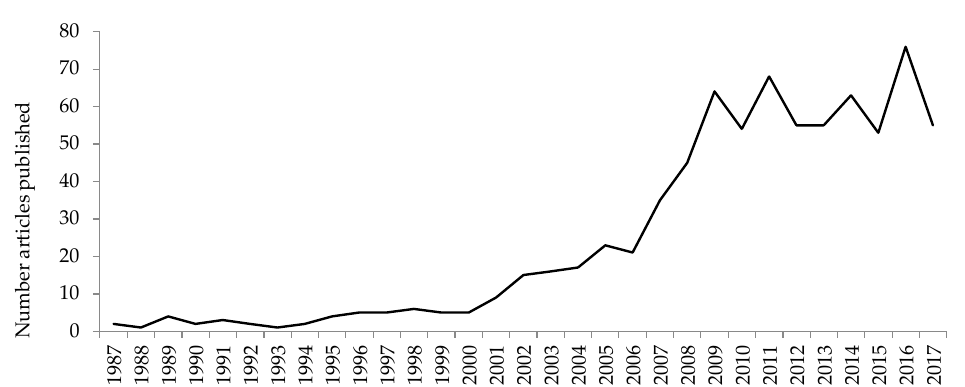
Figure 2. The number of articles published by year (1987–2017) exploring the use of fuzzy logic in finance has increased significantly since the mid-2000s.